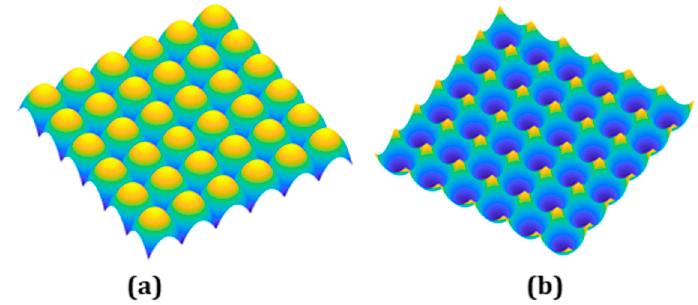
Figure 1. The 3D models of ( a ) convex and ( b ) concave lens arrays.